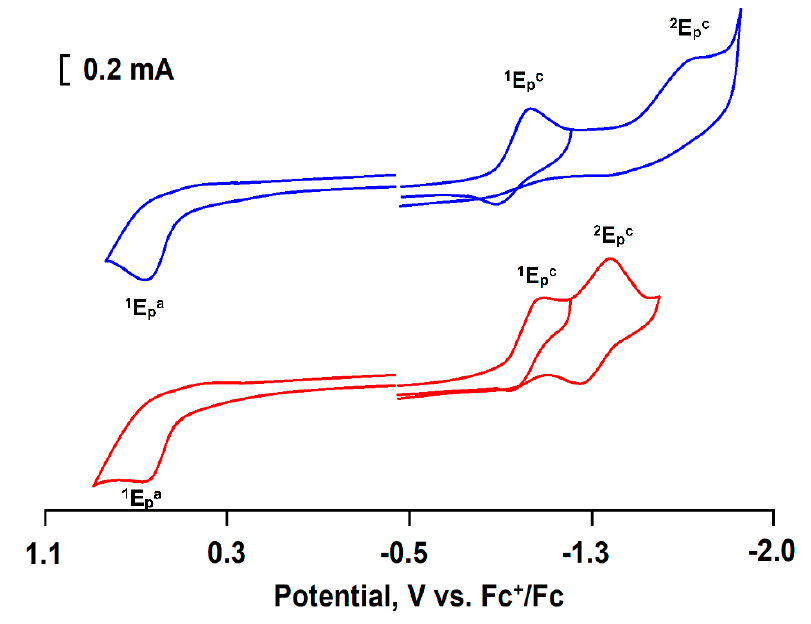
Figure 7. CVs for w/o Co II @SiO 2 (red) and Stöber Co II @SiO 2 (blue) WE: CPE, H 2 O, 10 − 1 mol·L − 1 Et 4 NBF 4 Et 4 NBF 4 Potentials vs. Ag / AgCl recalculated to Fc + / Fc. Potentials vs. Ag/AgCl recalculated to Fc + /Fc. Table 4. The potentials for Figure 7. Conditions: 25 ◦ C, working electrode: CPE (graphite + ionic